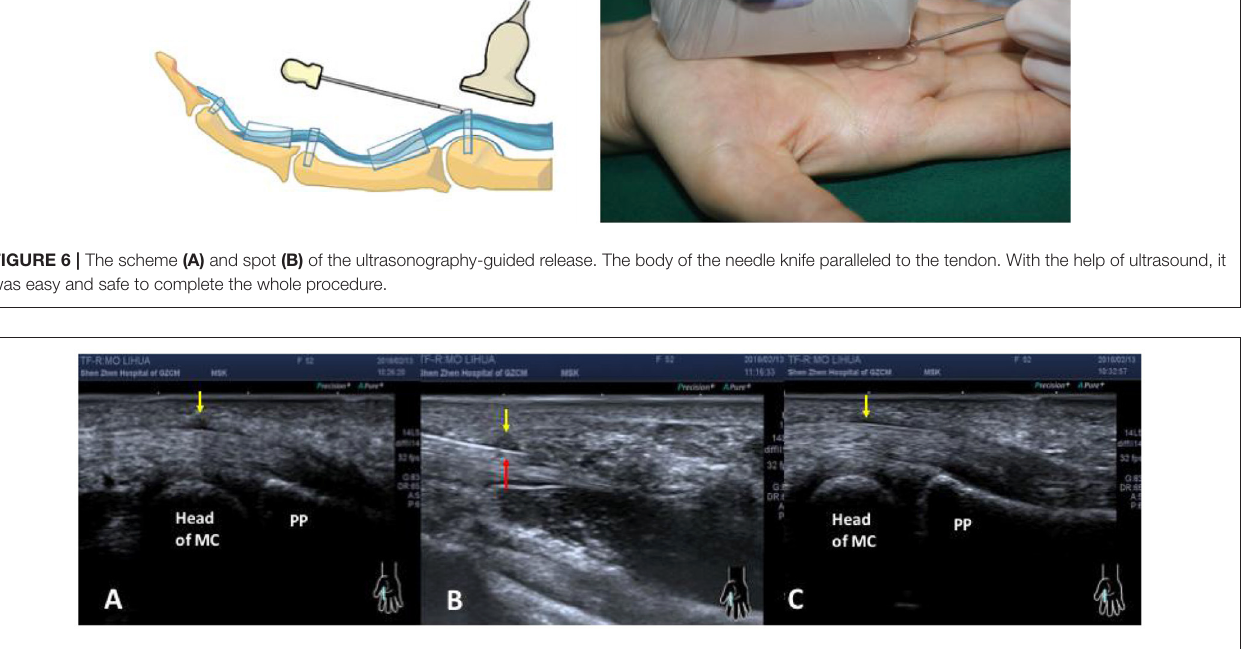
FIGURE 7 | The ultrasound images before (A) , during (B) and after (C) release with ultrasonography-guided. (A) The yellow arrow showed the thickening of A1 pulley in the right index finger before operation. (B) The red arrow showed the needle knife was cutting the A1 pulley (yellow arrow). (C) The A1 pulley (the yellow arrow) became normal thickness immediately after ultrasonography-guided release. PP, proximal phalange; MC, metacarpal